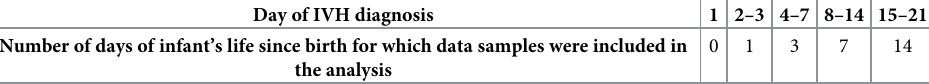
Table 2. Procedure adopted to select data samples of affected neonates to be input into the model. The procedure considers the day of occurrence of IVH. Day of IVH diagnosis Number of days of infant’s life since birth for which data samples were included in the